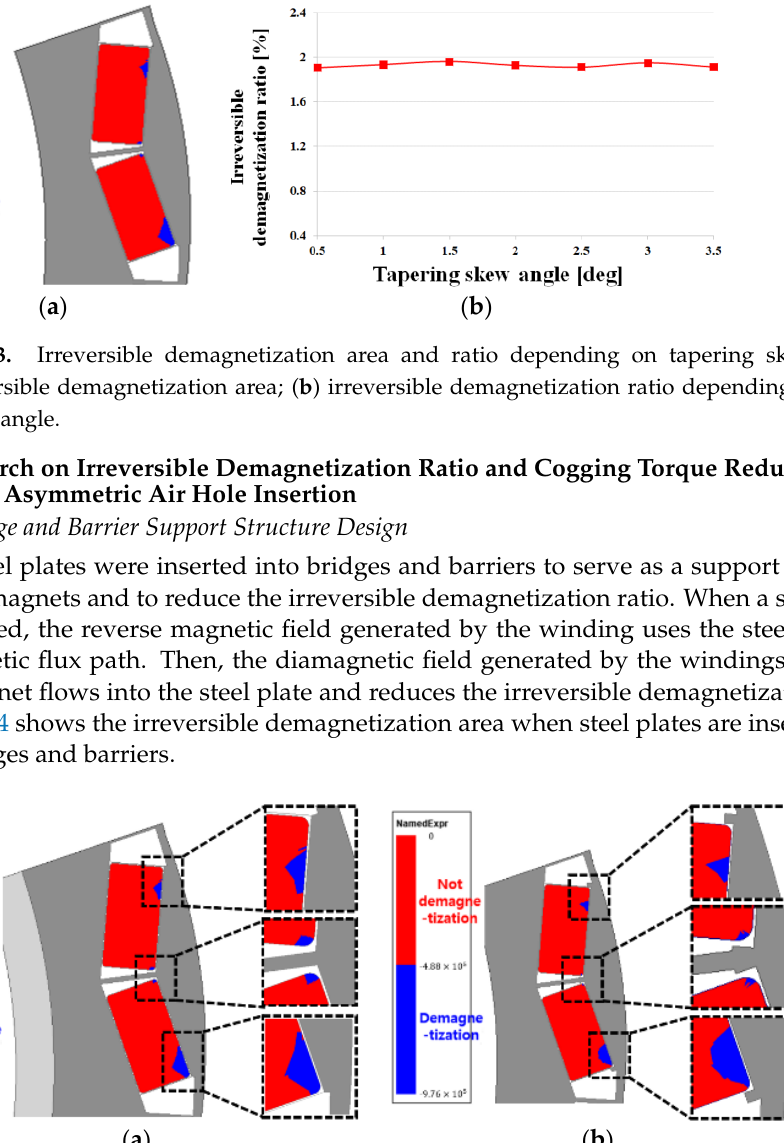
( b ) Figure 12. Back emf and cogging torque depending on tap L and tapering skew angle: ( a ) back emf; ( b ) cogging torque. Figure 12a shows the back emf depending on the tapering skew angle. As t ap L